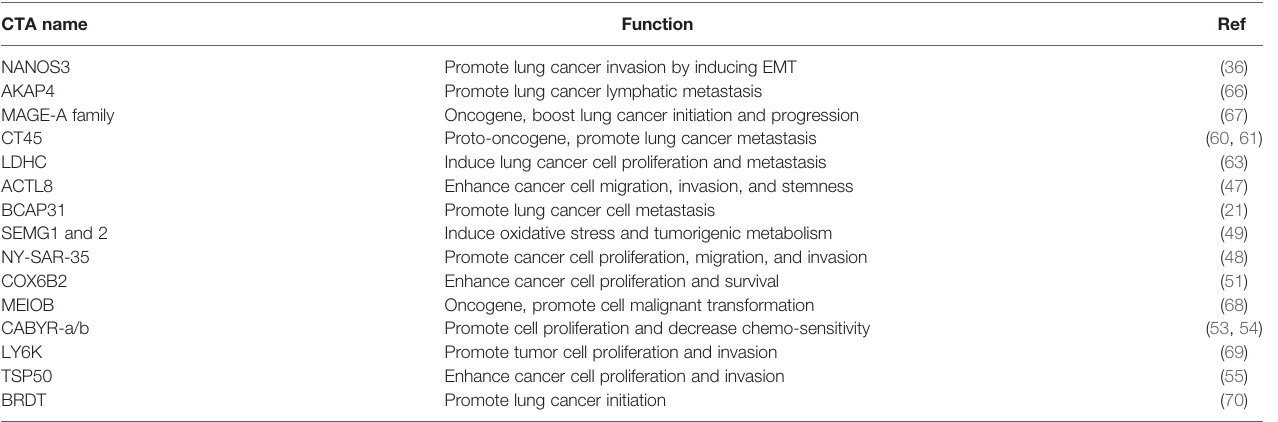
TABLE 1 | Oncogenic CTAs promote lung cancer initiation and